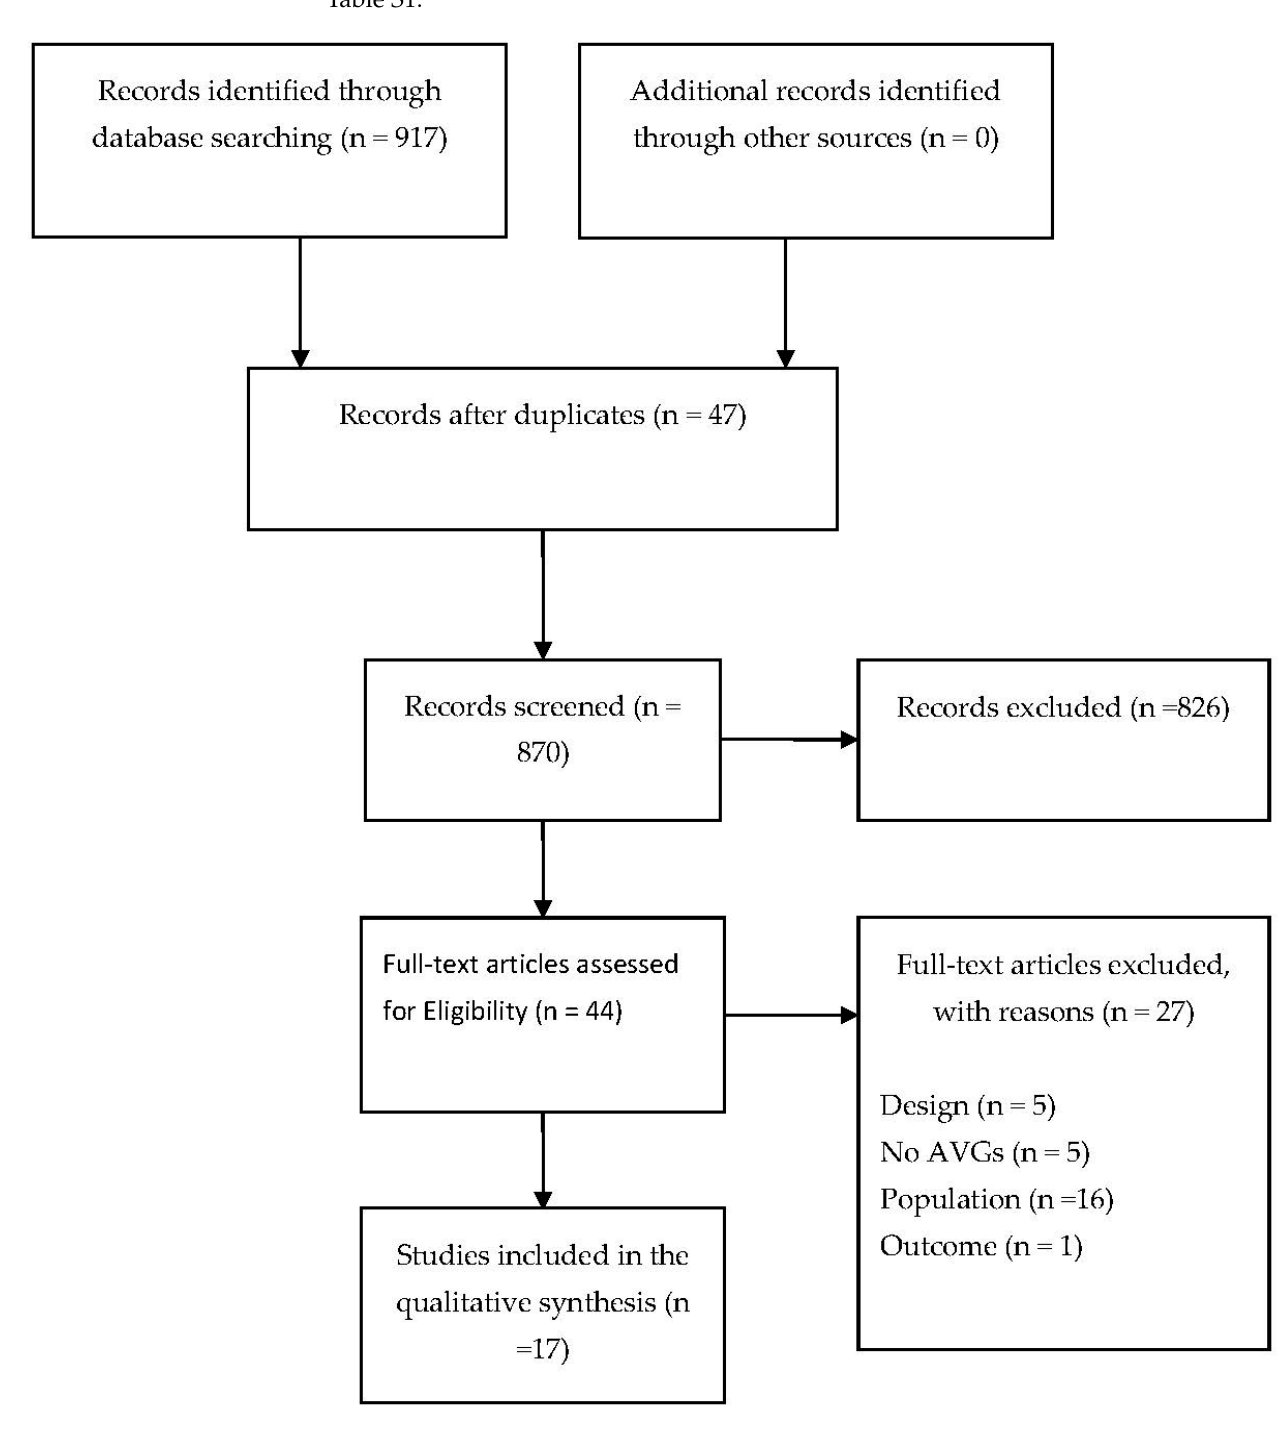
Figure 1. Study Flow diagram.